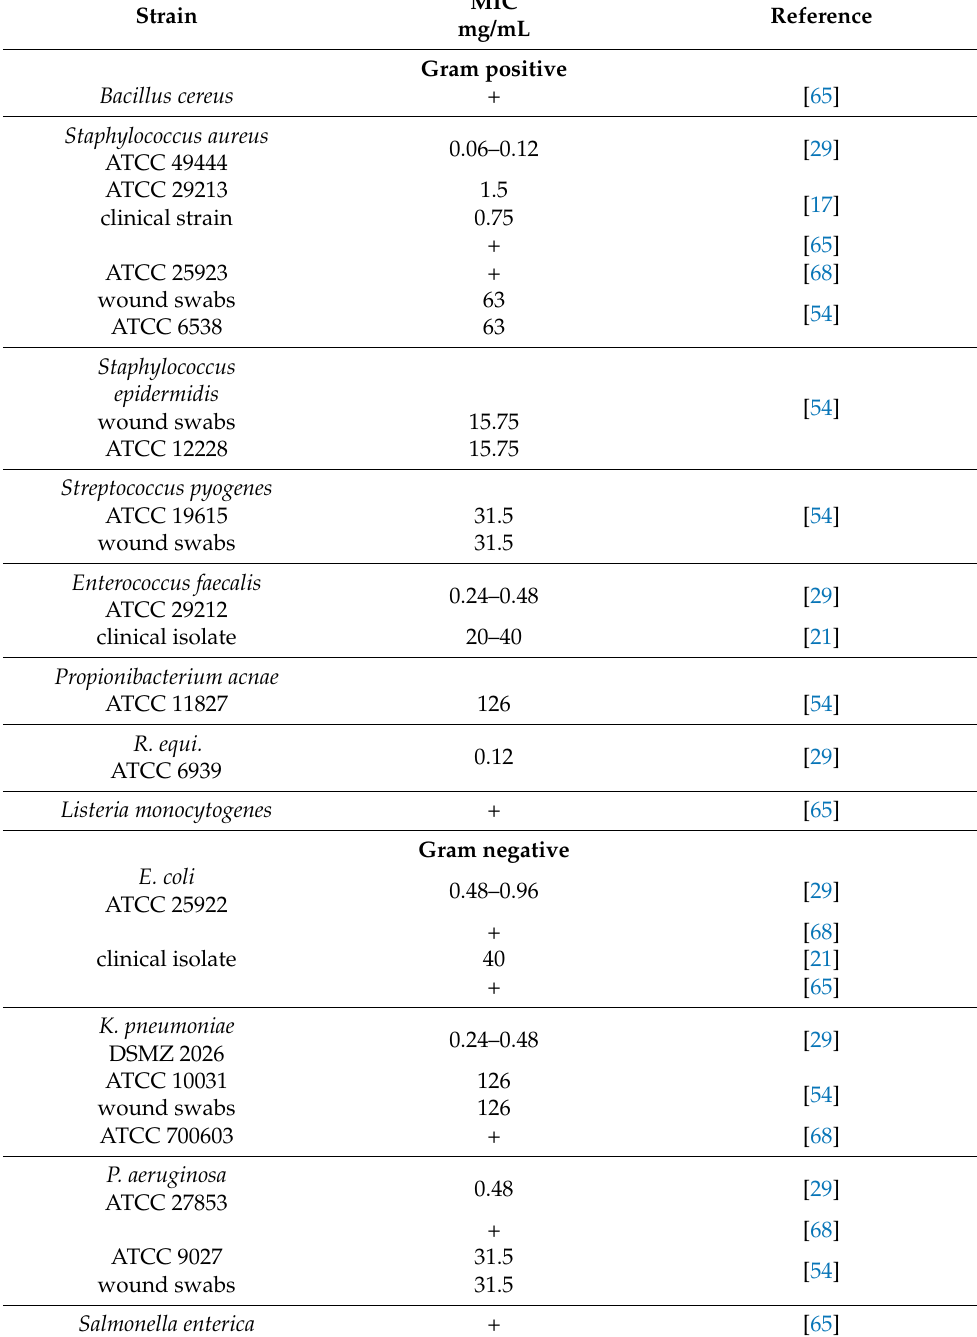
Table 8. Antibacterial and antifungal activity of VM leaf extracts.